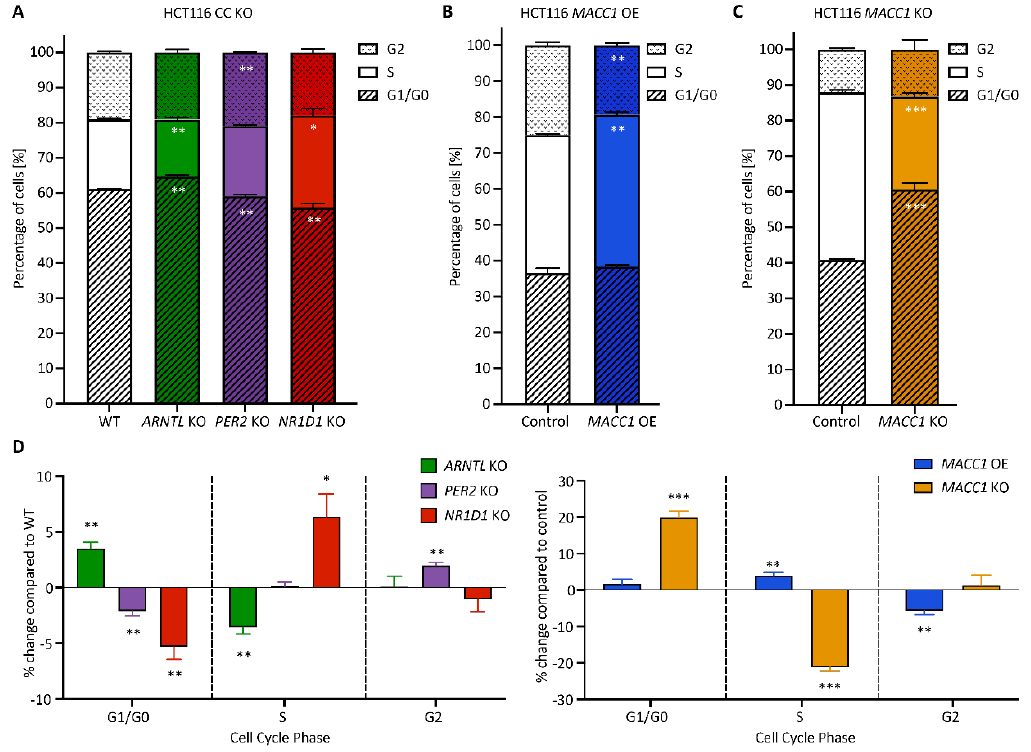
Figure 5. CC KO and MACC1 manipulation alter cell cycle dynamics in HCT116 . Cell cycle phase distribution in CC KO HCT116 cells ( A ) as well as ( B ) MACC1 overexpressing and ( C ) MACC1 KO HCT116 cells. ( D ) Normalized cell cycle phase distribution in CC KO and MACC1 manipulated HCT116 cells compared with WT or control, respectively ( n = 3, mean ± SEM, * p < 0.05, ** p < 0.01, *** p < 0.001; two-tailed unpaired t -test). Cells were synchronized and collected 24 h after synchro- nization.